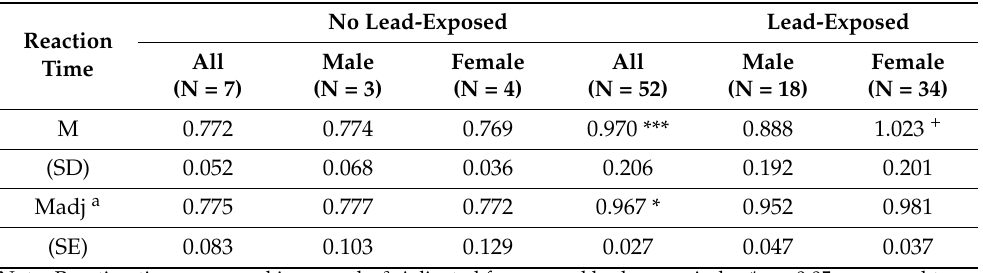
Table 3. Reaction time difference between gender and chemical exposure on occupation.